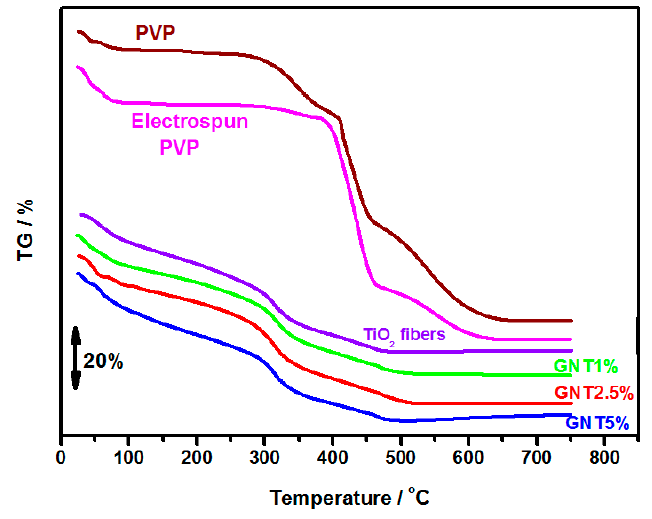
Figure 5. TGA curves of PVP, PVP fibers and prepared photocatalyst fibers before calcination.